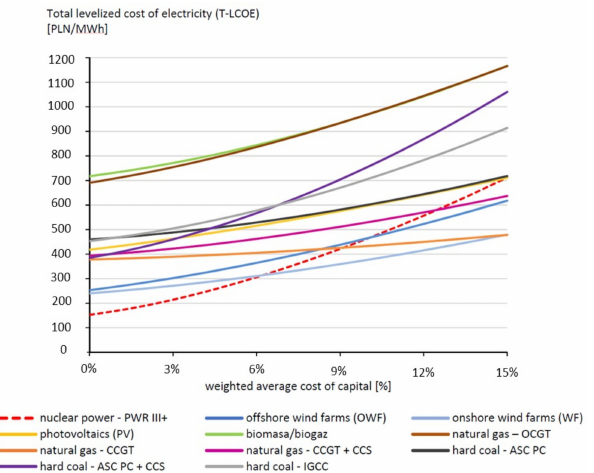
Figure 3. The lower the cost of capital, the lower the price of electricity from nuclear power plants. Sensitivity analysis of the total levelised cost of electricity (T-LCOE) in 2035. Variable: weighted average cost of capital (WACC). Constant: 30% penetration of the given variable RES technology the